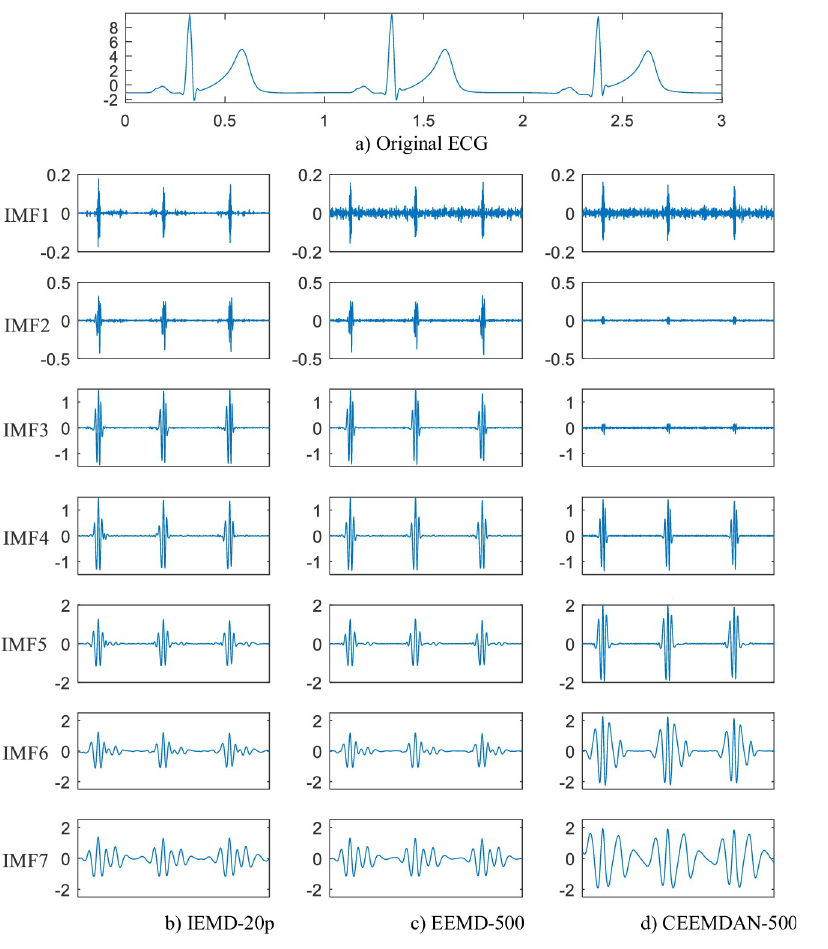
Fig 2. Comparison of the decomposition waveform (IMF1-IMF7).